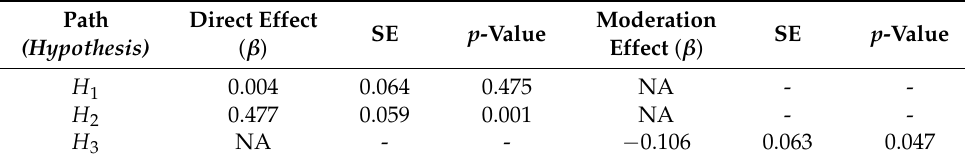
Table 5. Path coefficients for latent variables. Source: Author